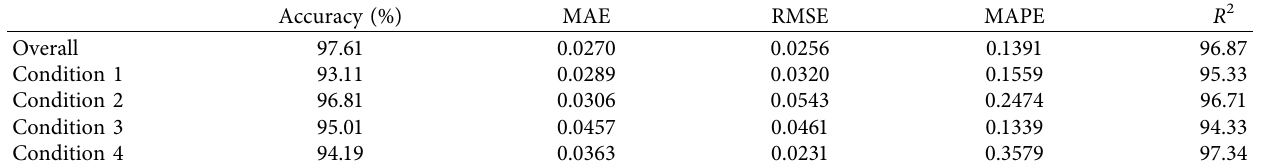
Table 7: Accuracy rates and evaluation index corresponding to different